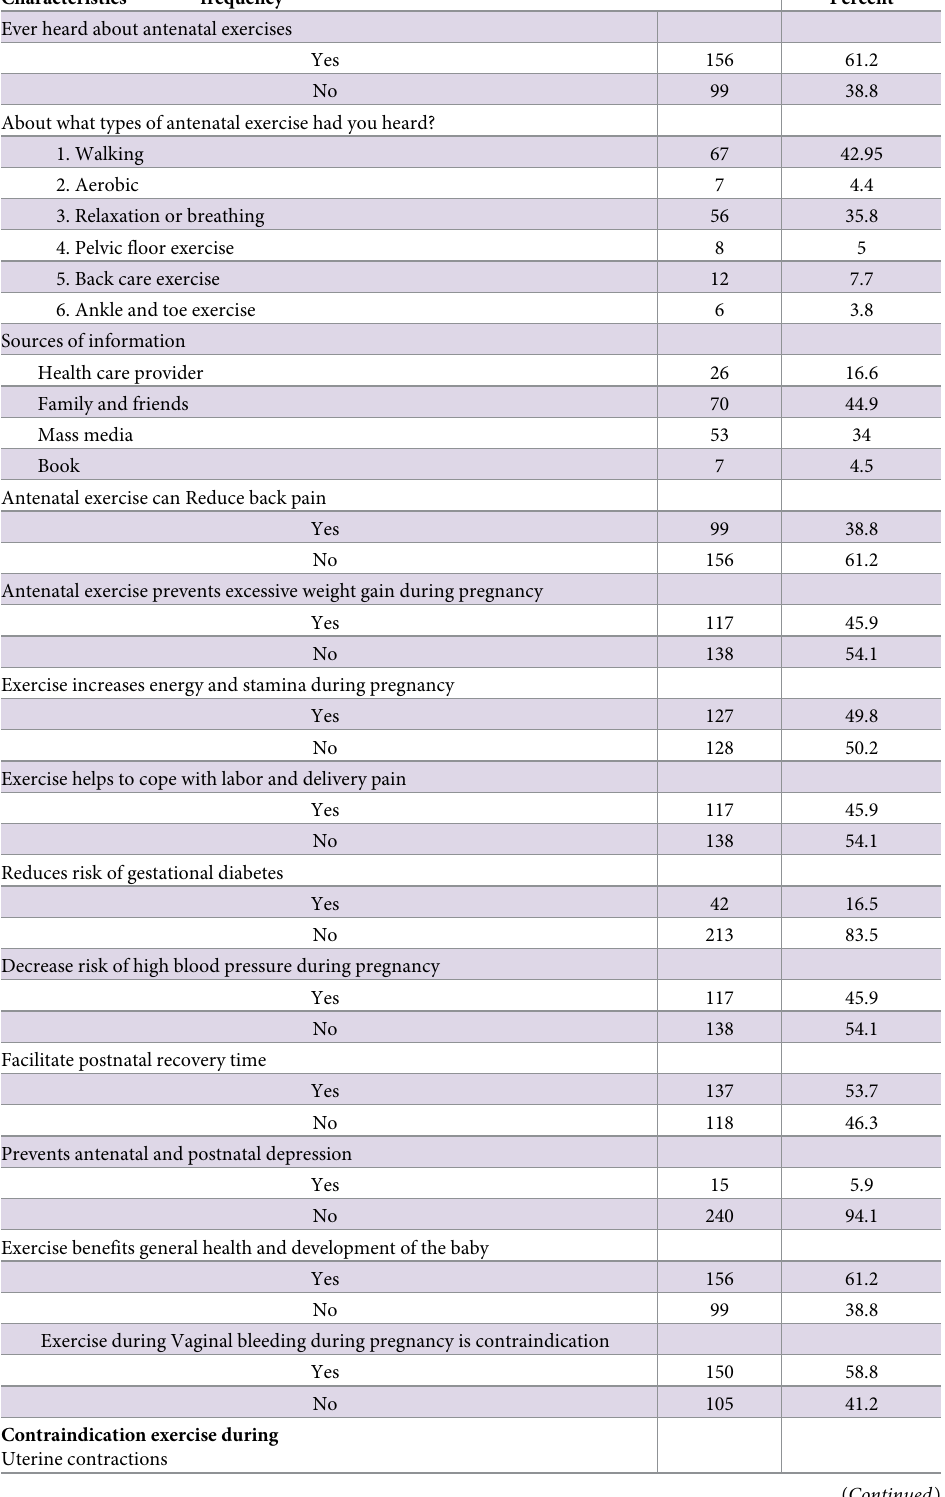
Table 2. Knowledge about the benefit and contra indication of antenatal exercise among pregnant women attend- ing ANC in Mekelle health centers, Tigray, Ethiopia, 2020.